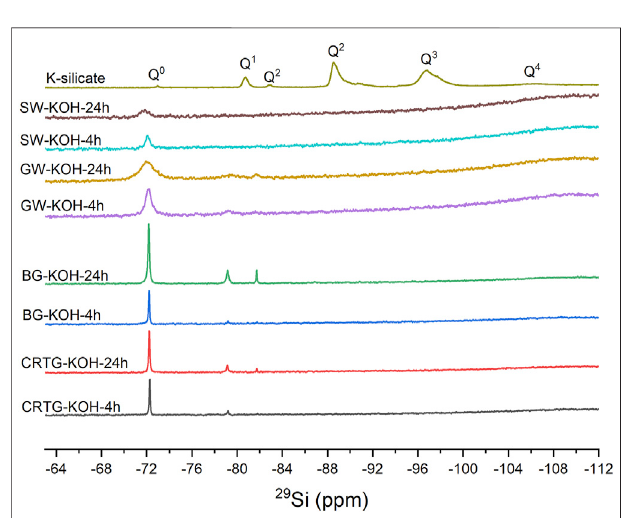
FIGURE 2 | 29 Si NMR spectra of the alternative activator